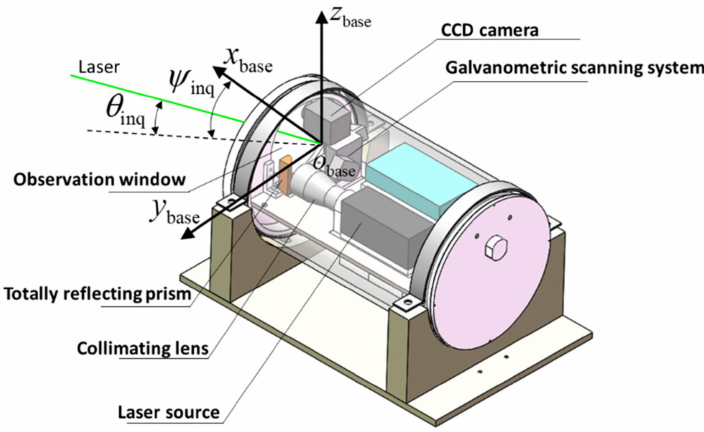
Figure 2. Major components and coordinate system of the base